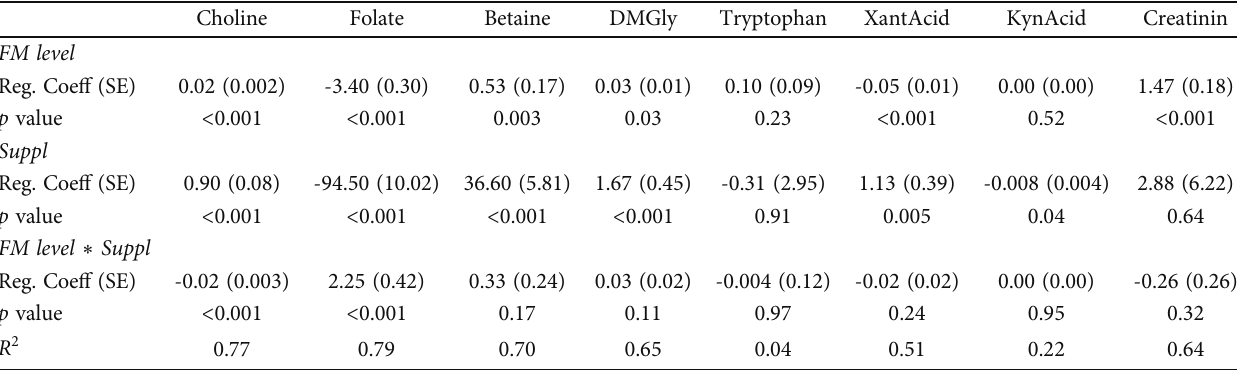
Table 8: Relationship between dietary FM levels, diet supplementation, and plasma biomarkers observed by targeted metabolome assays directed towards the estimation of the level of metabolites involved in the metabolism of choline and related B-vitamins † ∗ .